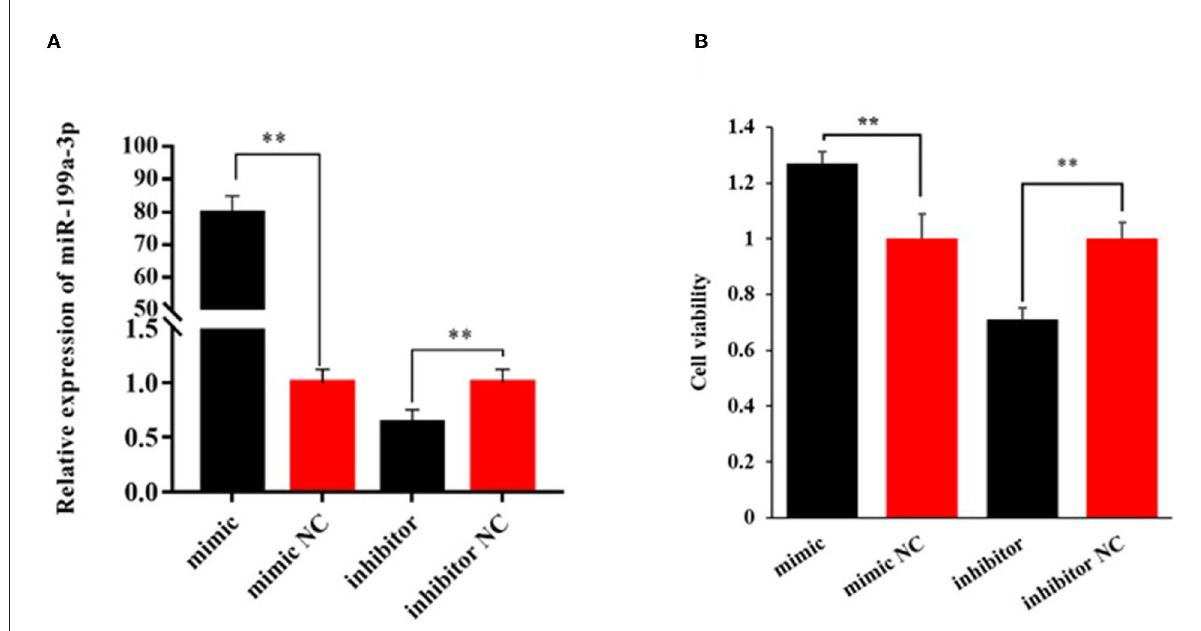
FIGURE1 Relative expression level of miR-199a-3p (A) and its effect on the viability of ovine mammary epithelial cells (OMECs) (B) when miR-199a-3p mimic and miR-199a-3p inhibitor were transfected into OMECs. ** P <